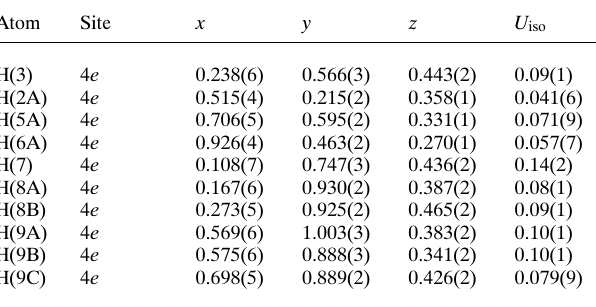
Table 2. Atomic coordinates and displacement parameters (in Å 2 )